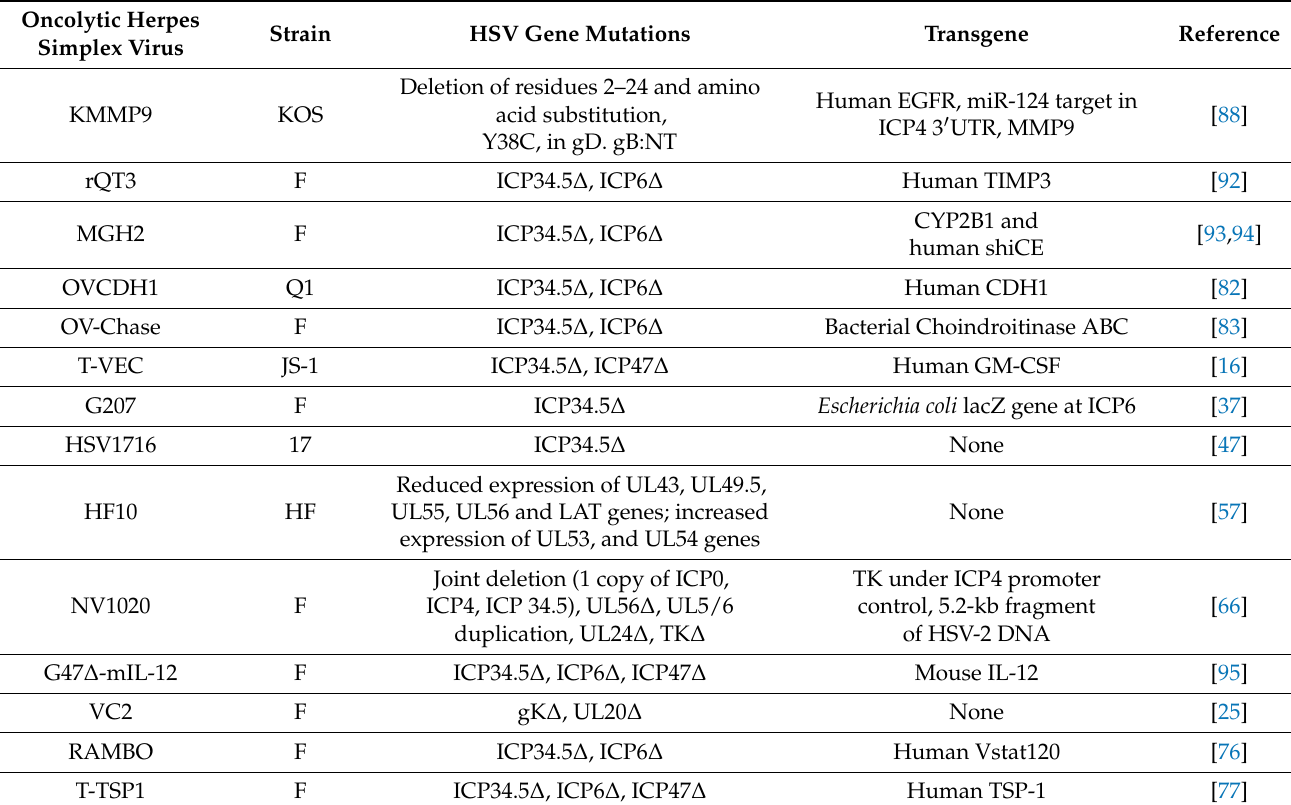
Table 1. Summary of HSV-derived Oncolytic Viruses